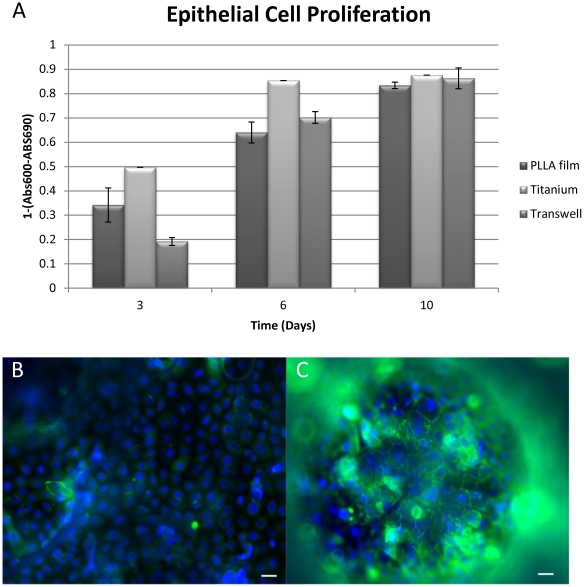
Epithelial cell proliferation and positioning.a) Human respiratory epithelium growth on transwell (positive control, hybrid implant with a nanoporous PLLA film and hybrid implant without a film b)presence of the film layer kept the epithelium on the same level for promoting the monolayer formation c) whereas in the absence of the film, epithelial cells grew on different levels (Scale bars: 10 µm).